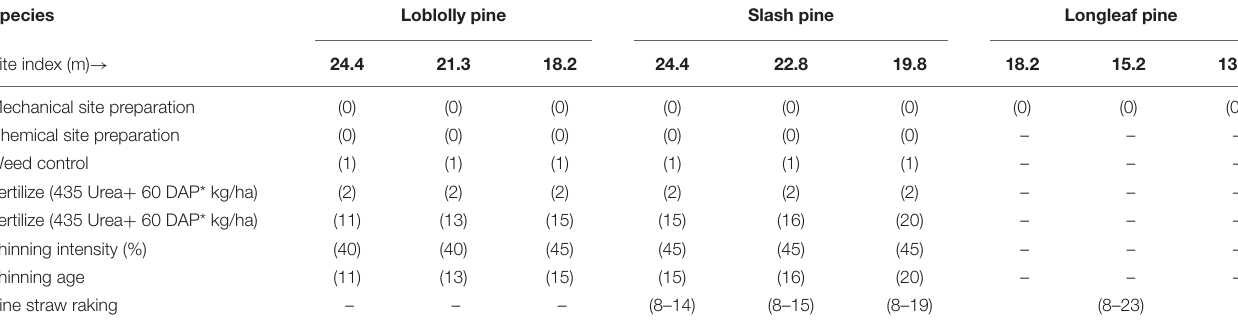
TABLE 2 | Silvicultural treatments for selected scenarios at different years for loblolly, slash, and longleaf pines. Species Loblolly pine Slash pine Longleaf pine